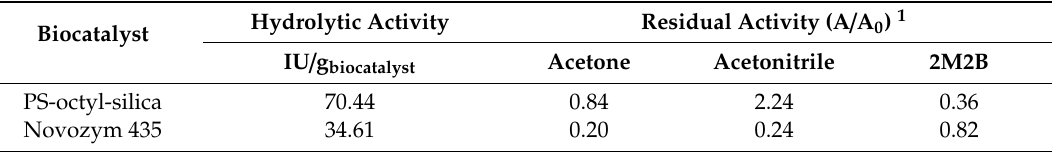
Table 1. Characterization of lipase